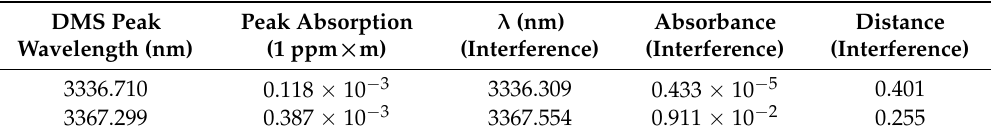
Table 1. Candidate regions for measurement of DMS concentration based on PNNL and HITRAN databases